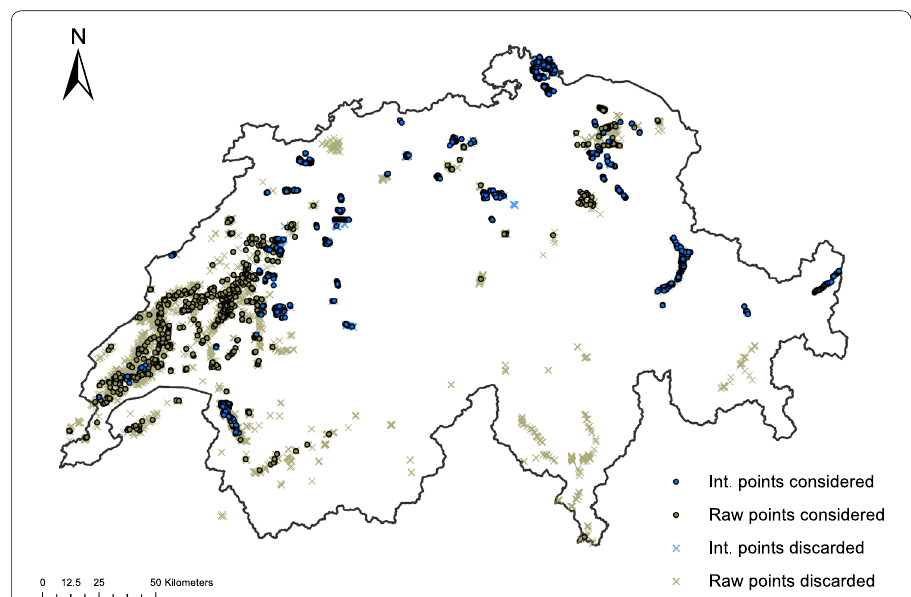
Fig. 9 Vertical Electrical Sounding data point locations in Switzerland. “Int” stands for “Interpreted”